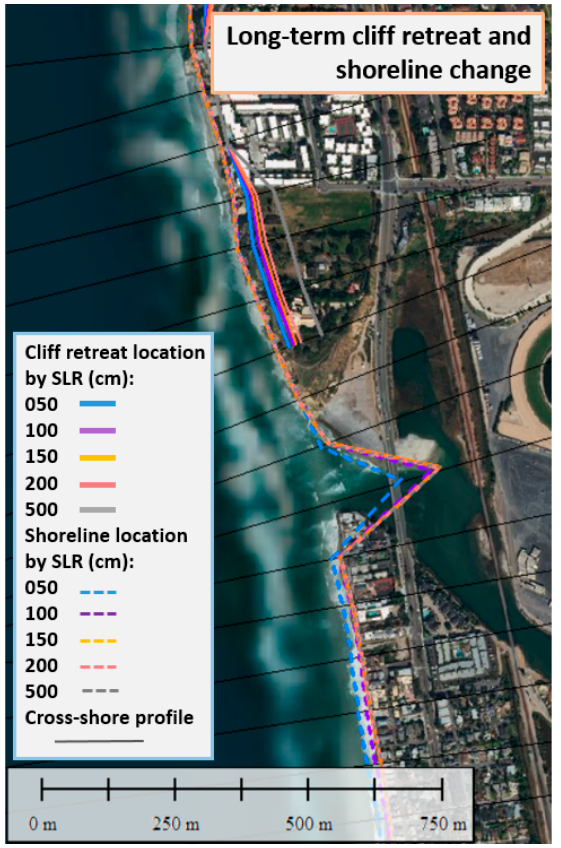
Figure 13. Long-term projected cliff retreat (solid colored lines) and sandy beach shoreline change (dashed lines) for various SLR at seaward lagoon entrance of Del Mar, California. In this projected management scenario, sandy beach erosion is limited to the urban boundary, and cliff retreat limited in locations with existing coastal armoring. Cross-shore transect/profile locations, at which long-term changes were derived, are shown by black lines. Cliff retreat projections are made only for transects with existing coastal cliffs/bluffs. Note that sandy beach projections converge for SLR 150–500 cm for a large portion of this area; all projections converge/show no change in locations where beach width is minimal (e.g., at the foot of the cliffs north of the lagoon mouth).